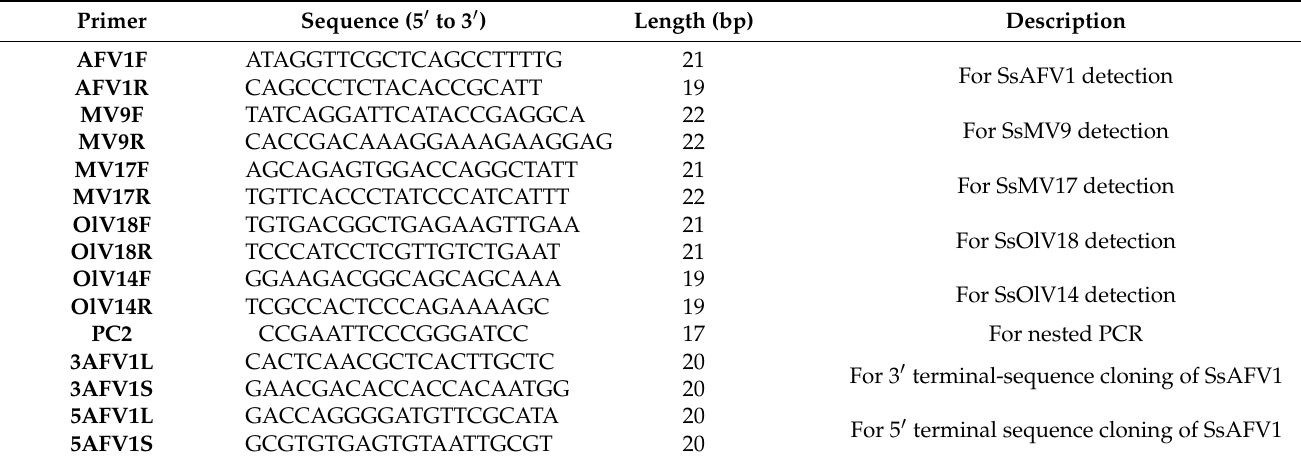
Table 1. Primers involved in this